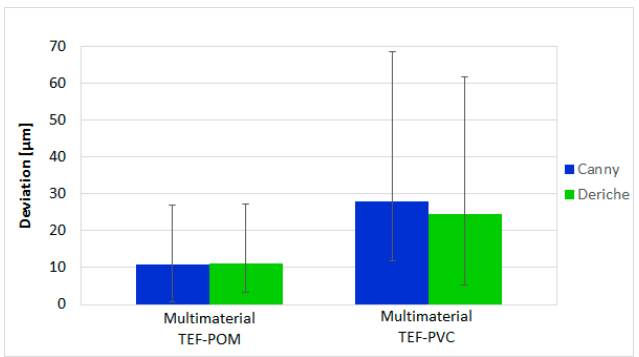
Figure 10. Average deviation for the Canny-based method (blue bars) and Deriche-based method (green bars) and maximum and minimum deviation (error bars) of all the part dimensions from their calibrated absolute values of multimaterial workpieces.